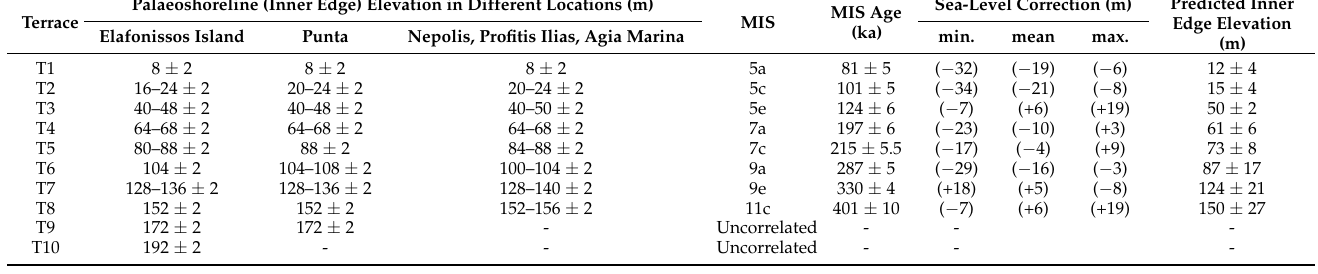
Table 3. Name, assigned MIS, age, and observed present-day elevations of the inner edges of the marine terraces in three different locations of the study area. The predicted (or expected) elevation ranges of the inner edges (palaeo-shorelines) for each MIS were calculated under the assumption that the long-term uplift rate (0.36 ± 0.11 mm a − 1 ) was constant over the last 401 ± 10 ka and taking into account the duration of each MIS (according to Lisiecki and Raymo [88], as well as the maximum and minimum position of eustatic sea-level for each MIS highstand (according to sea-level curve by Waelbroeck et al. [25].